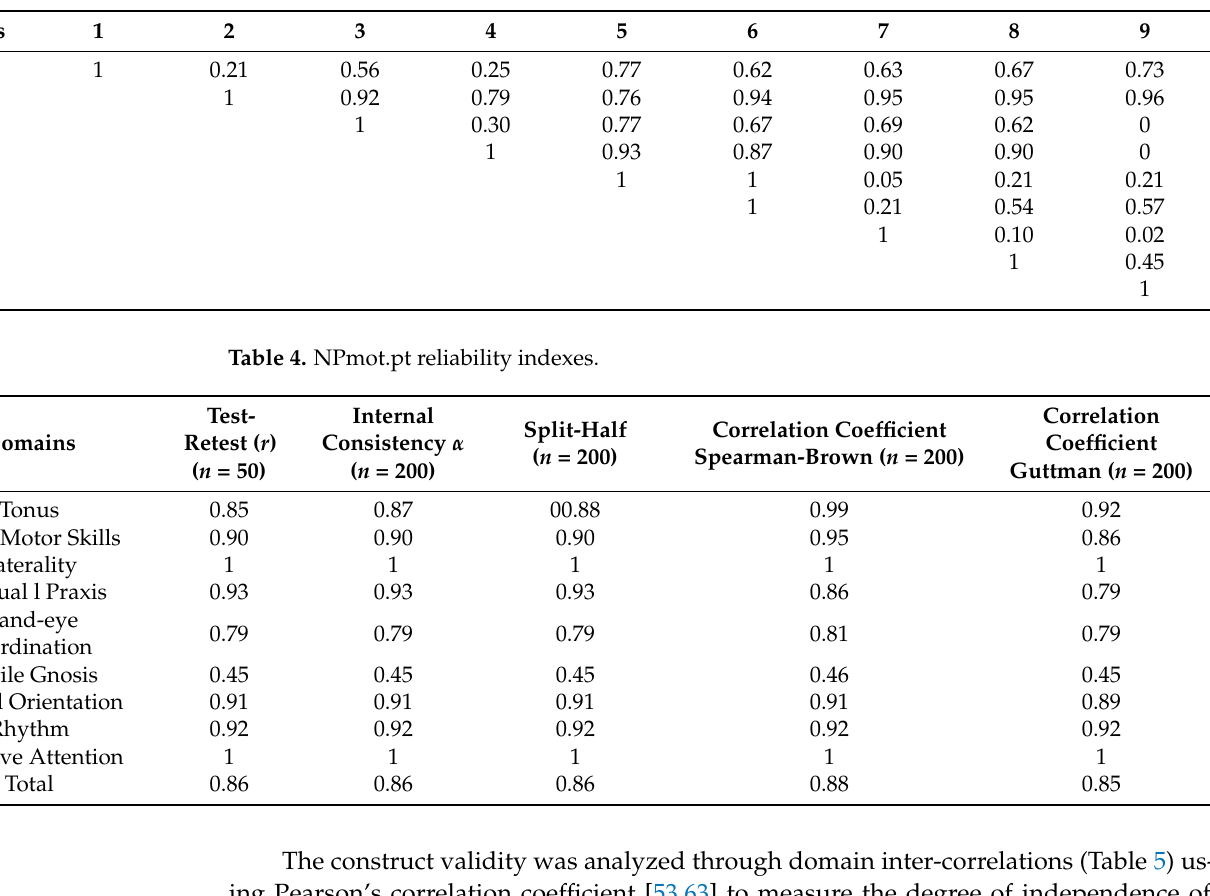
Table 3. Content validity—Cohen’s kappa.